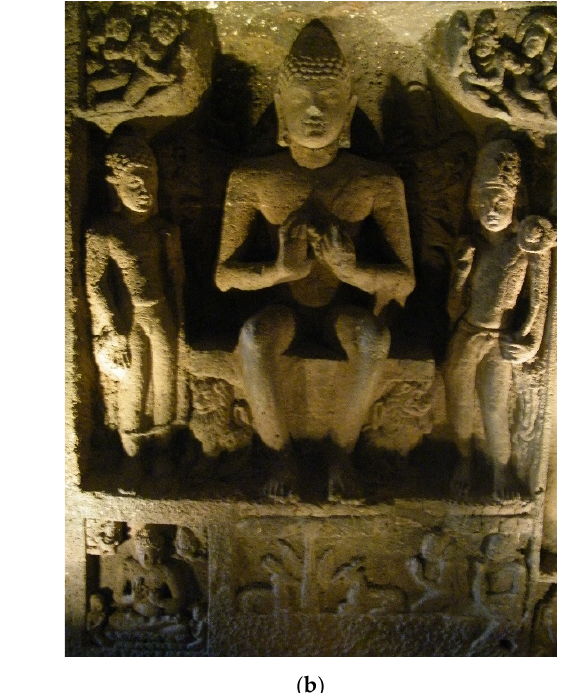
Figure 13. Intrusive panels with triads from Aja ṇṭ ā Cave 26, circumambulatory wall; ca. 478–480 CE: ( a ) central Bhadr ā sana Buddha flanked by two standing Buddhas; ( b ) central Bhadr ā sana Buddha attended by a standing Buddha and a standing Bodhisattva(Photographs by the author).